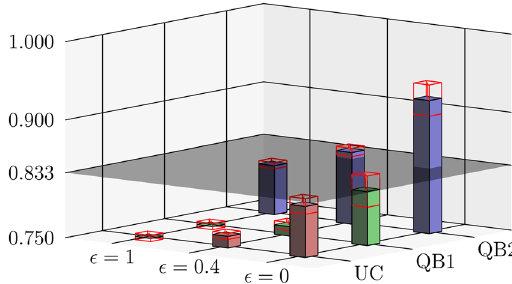
Fig. 6 Experimentally measured average cloning fi delity F i for quantum banknotes 1 and 2 (QB1 and QB2), and optimal universal cloning (UC). The red frames show the error bars of the measured probabilities. The veri fi cation threshold (gray surface) is set at 0.833, which is the fi delity of the optimal universal cloning process, i.e., the process that ignores any information about